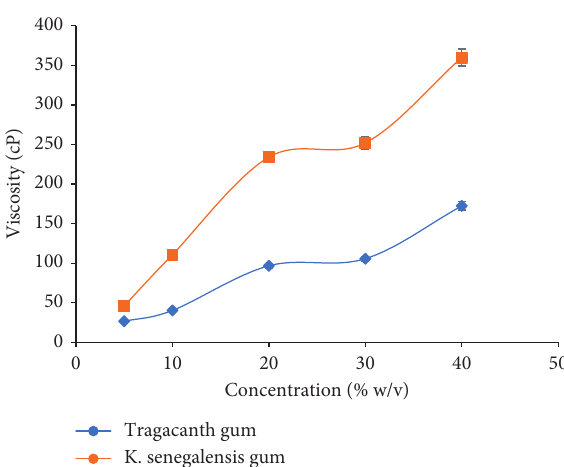
Figure 3: Plot of concentration with respect to viscosity. The error bars represent standard deviations for 5 concentrations in three separate sample runs ( n � 15).